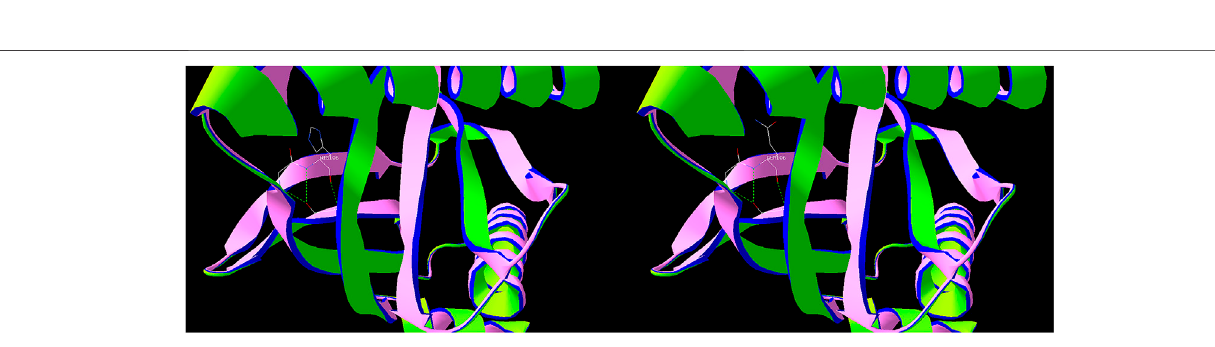
Frontiers in Molecular Biosciences |